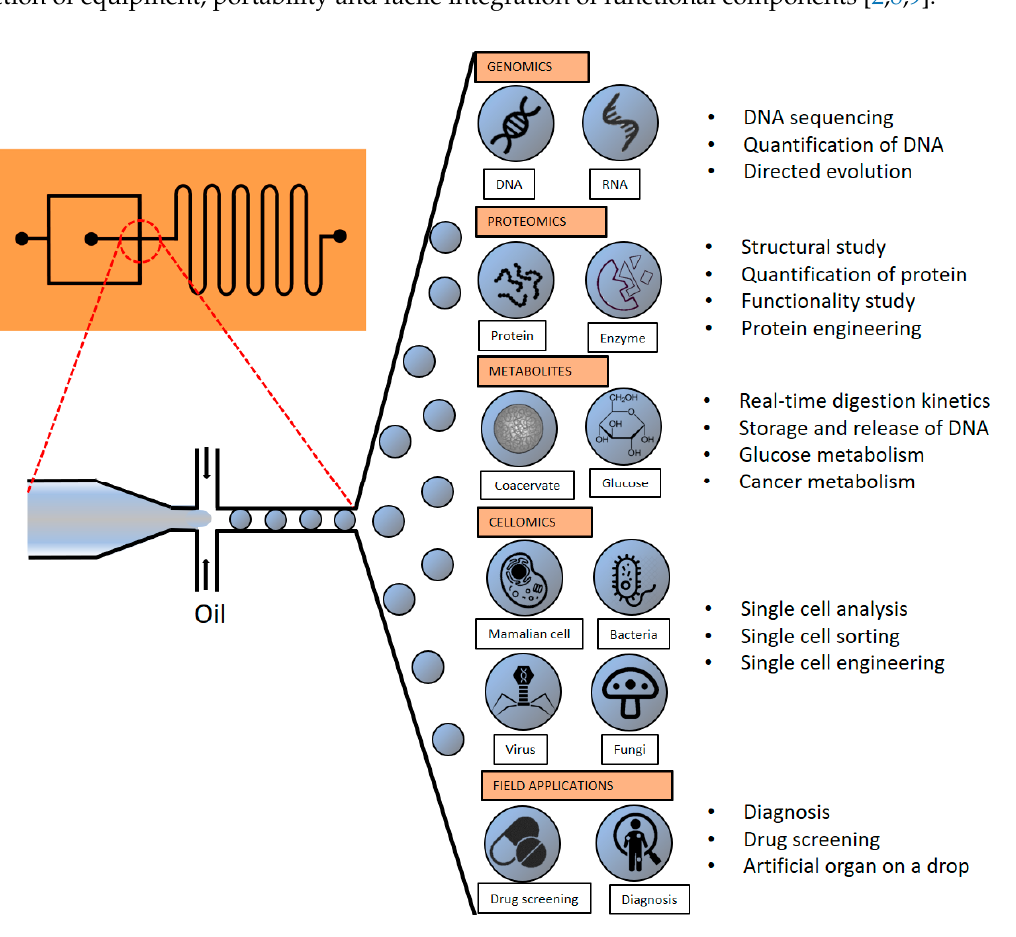
Figure 1. Schematic diagram of biological components that can be analyzed and engineered using droplet-based microfluidics (DMFs).